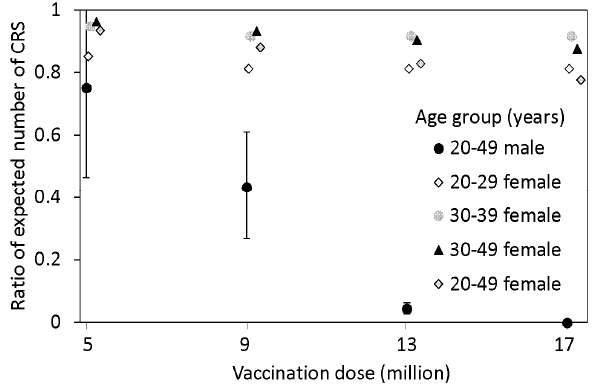
Figure 4. Ratio of the expected number of congenital rubella syndrome (CRS) cases under the SIP to that without the SIP. Dots represent the ratios under different SIP scenarios with an identical subject for vaccination. Whiskers describe the 95% confidence intervals of each ratio, for males only.